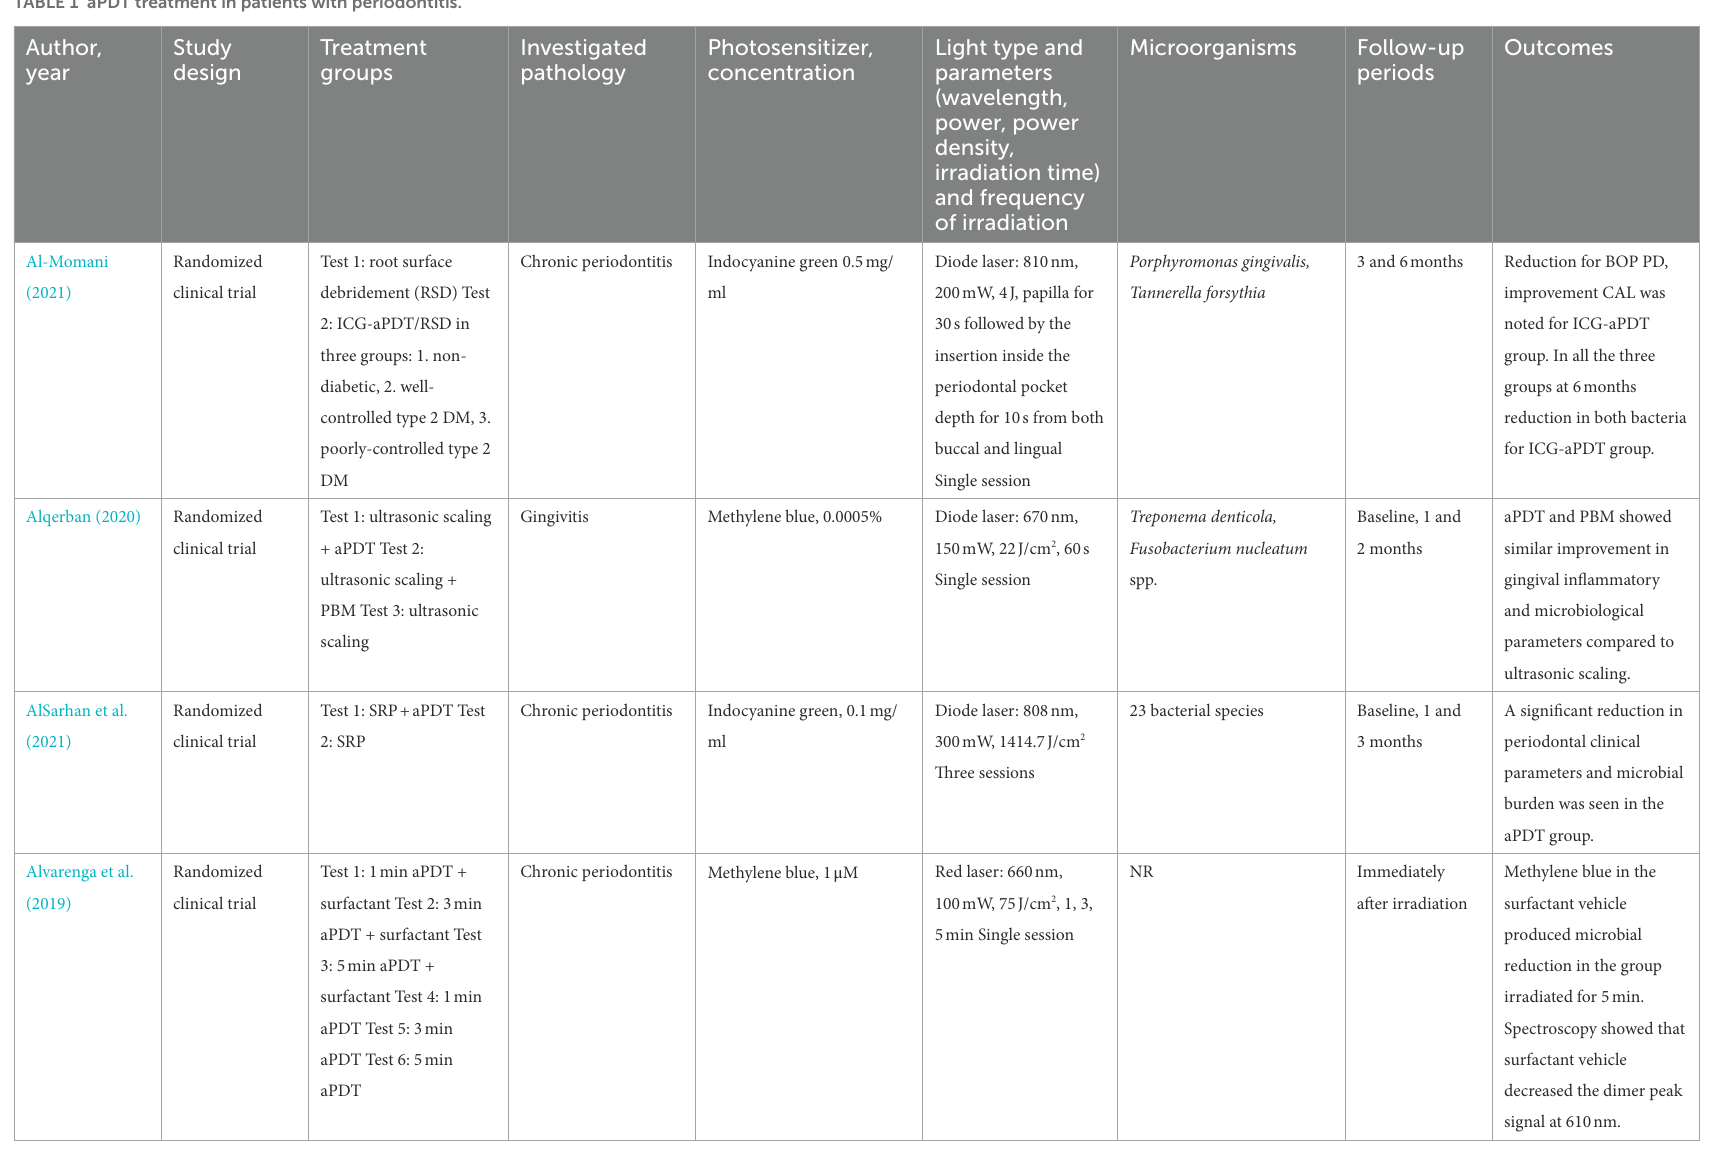
TABLE 1 aPDT treatment in patients with